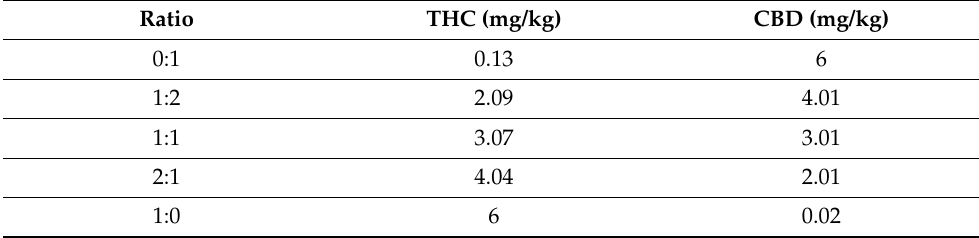
Table 4. Dose of cannabinoid administered at each ratio for THC and CBD